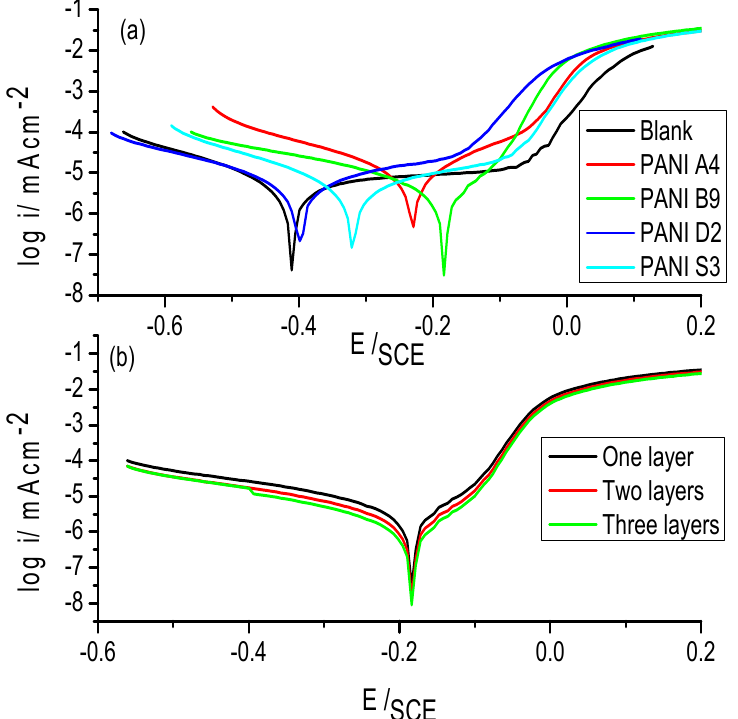
Figure 12. ( a ) Tafel plot of uncoated and different PANI coated stainless steel with different samples, as indicated. ( b ) Tafel plot of PANI coated via different no of drops on steel.